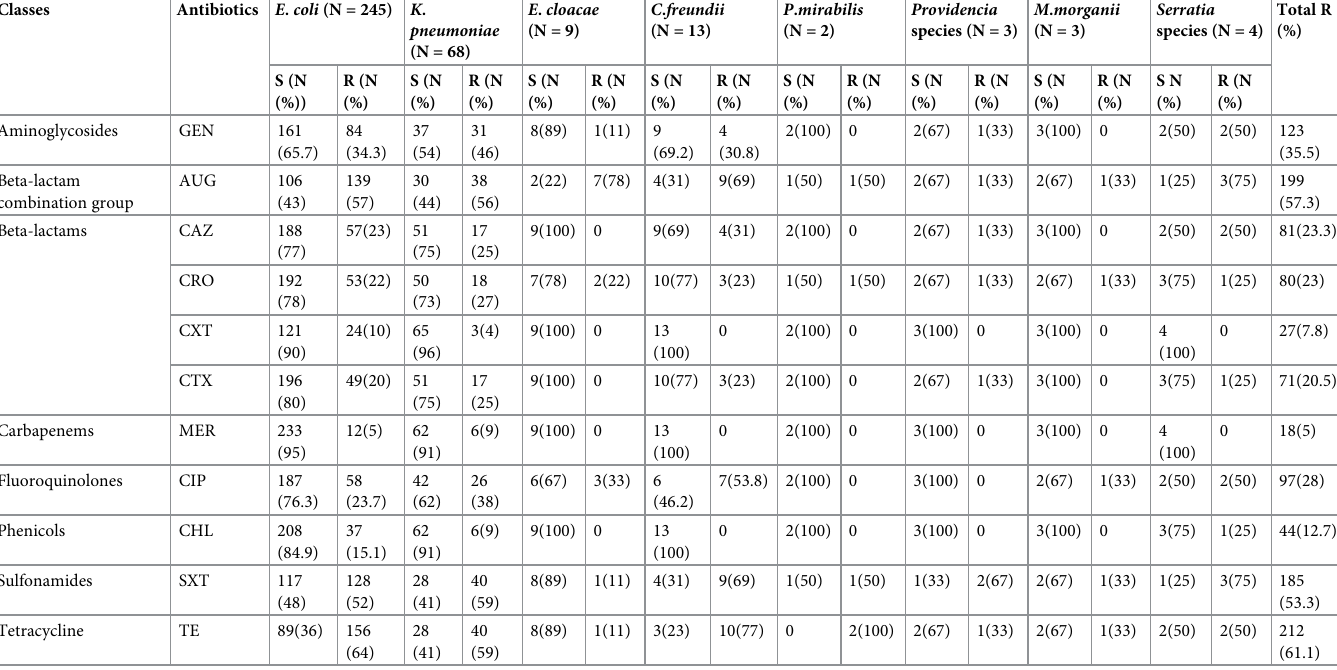
Key: S = Sensitive, R = Resistance, AUG = Augmentin/Amoxicillin/clavulanic acid; SXT = Sulphamethoxazole-trimethoprim; TE = Tetracycline; CIP =